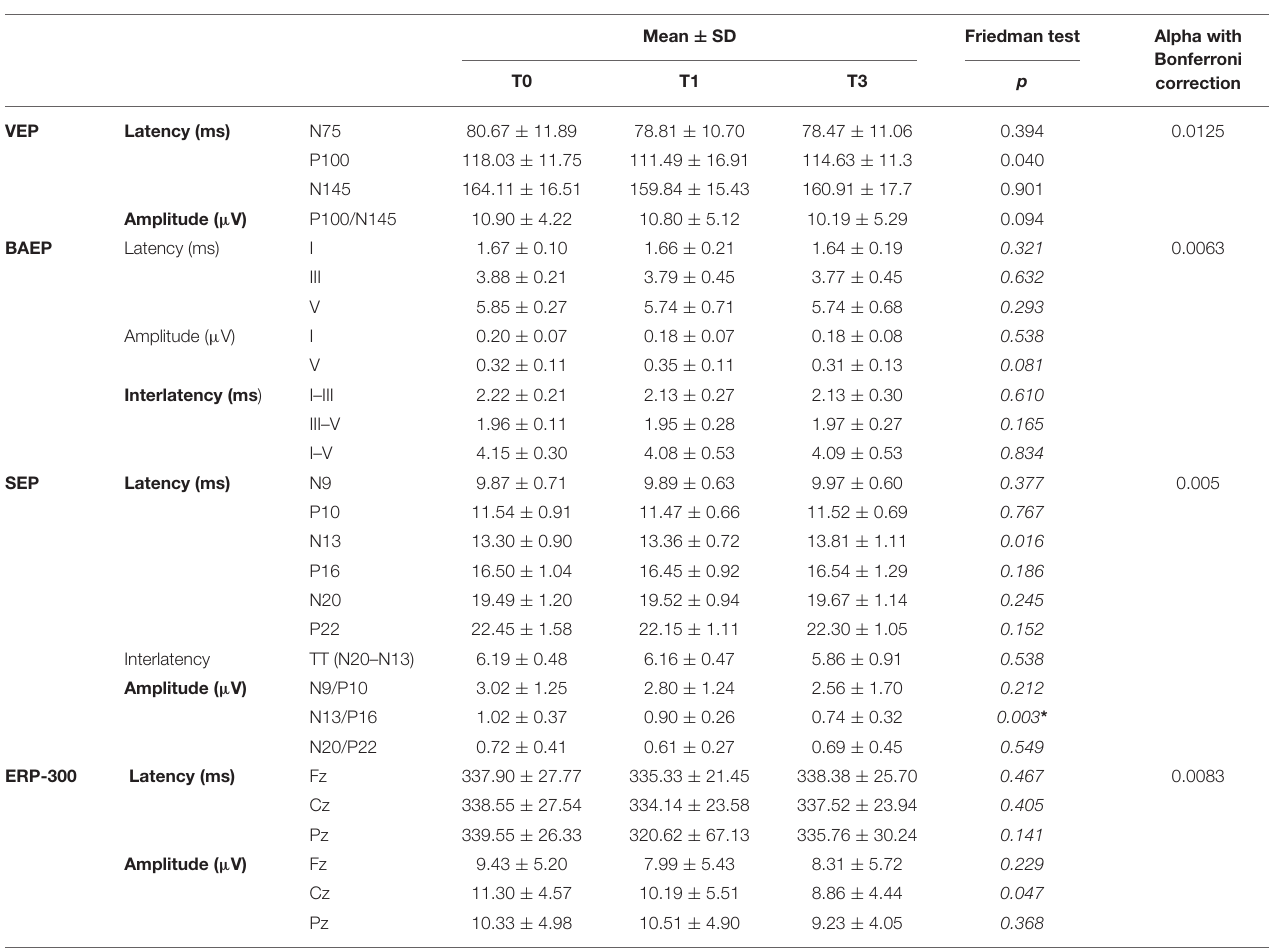
TABLE 3 | Comparison of EP parameters evaluated at T0, T1, and